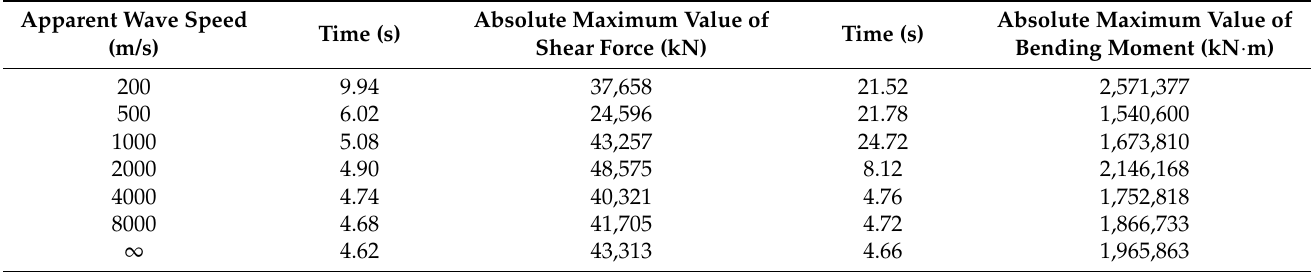
Table 10. Absolute maximum of internal force at the bottom of 3# main tower at different visual wave